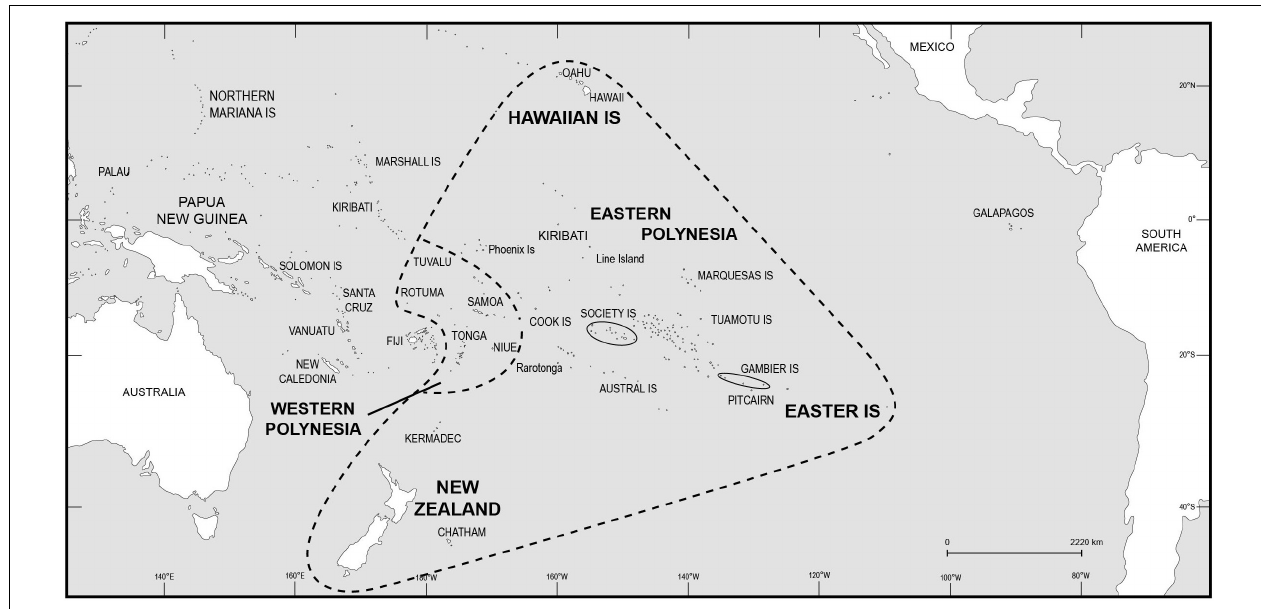
FIGURE 1 | Map of Eastern Polynesia and location of the Society Islands and Gambier Islands (Mangareva).